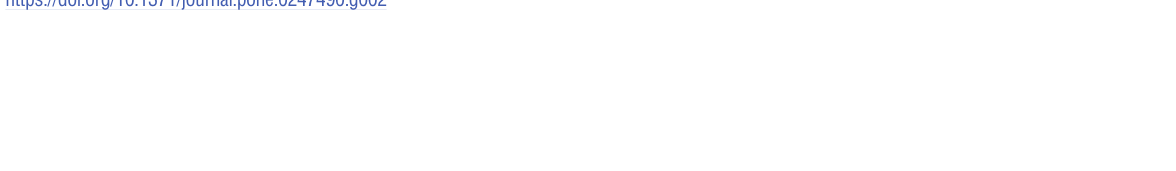
PLOS ONE | https://doi.org/10.1371/journal.pone.0247490 February 24,